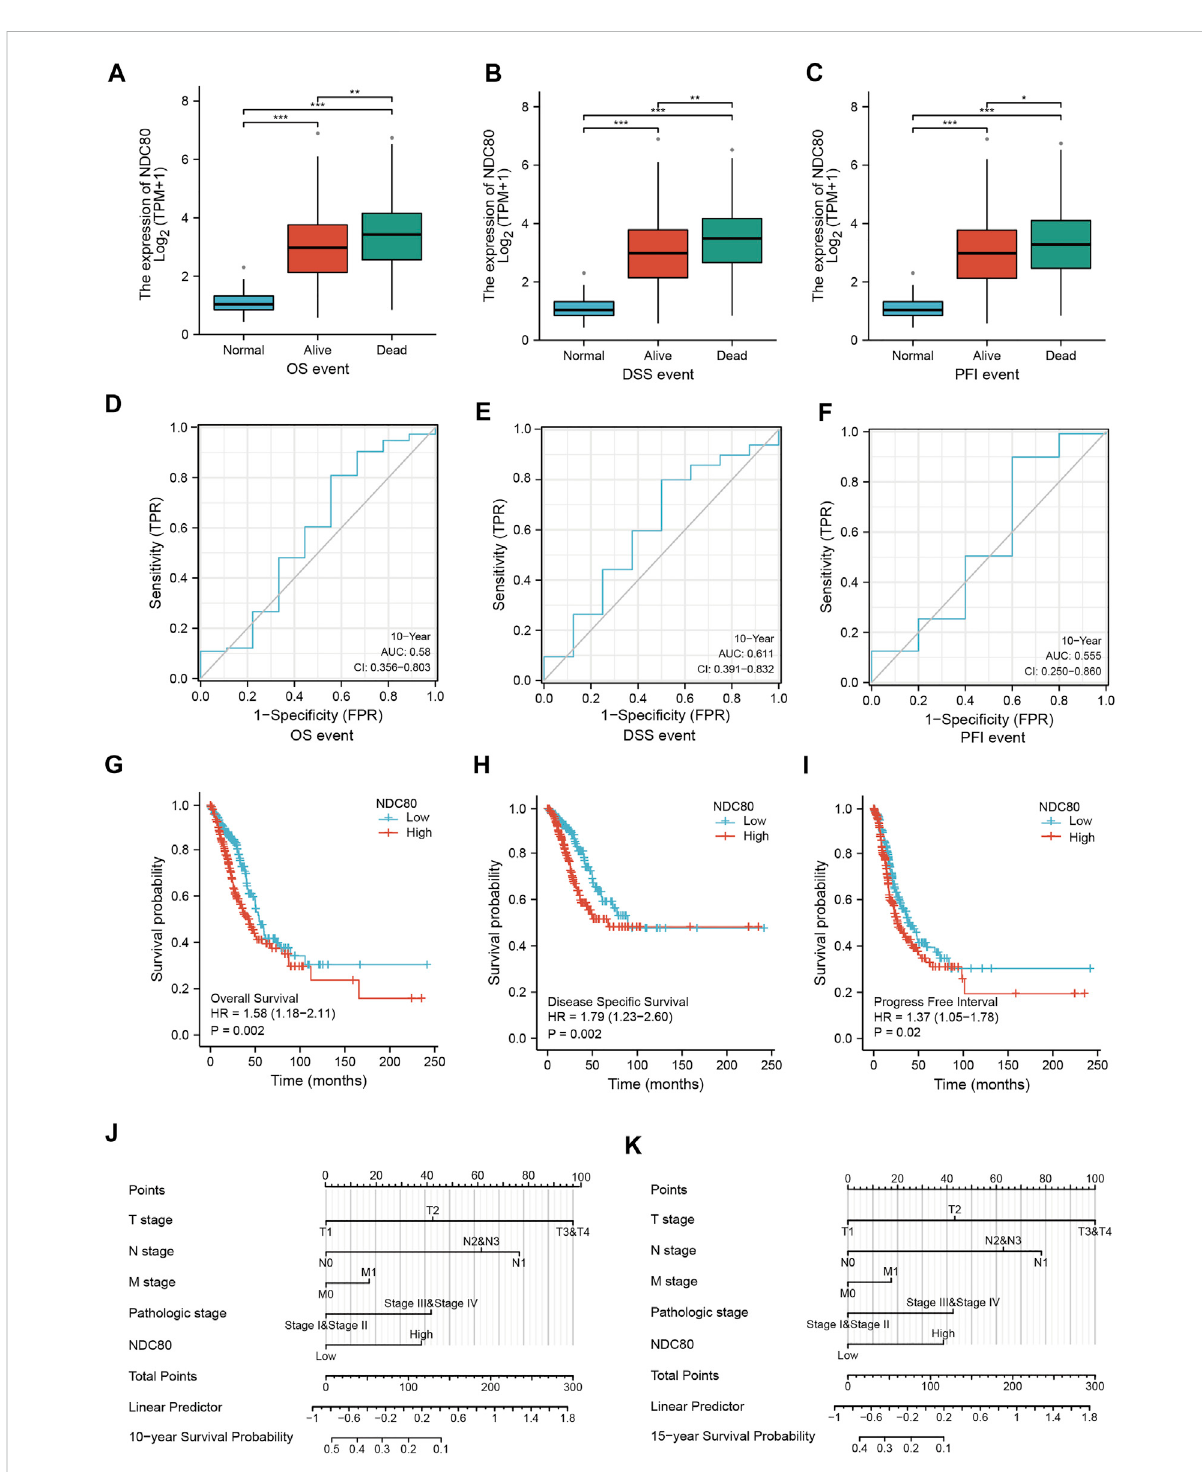
FIGURE 3 The prognostic value of NDC80 in LUAD. (A – C) Using the XianTao tool, the NDC80 expression level was compared among healthy control individuals, and surviving and dead LUAD patients with regard to their OS (A) , DSS (B) , and PFI (C) . (D – F) The AUC values of time-dependent ROC curves were used to verify the 10-years prognostic risk score for OS (D) , DSS (E) , and PFI (F) , based on NDC80 expression levels, using the XianTao tool. (G – I) Generation of survival curves for the OS (G) , DSS (H) , and PFI (I) of patients in the high-expression and low-expression groups using the XianTao tool. (J,K) The prognostic nomogram of LUAD for the 10-years (J) and 15-years (K) survival period is based on NDC80 expression levels using the XianTao tool. * p < 0.05; ** p < 0.01; *** p <